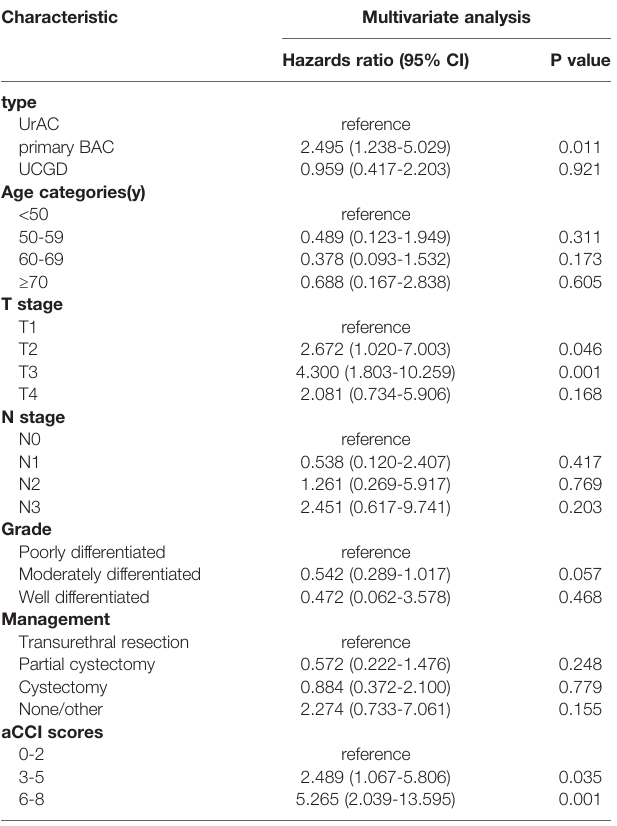
TABLE 3 | Association of factors with overall survival on multivariate Cox proportional hazards regression analysis.